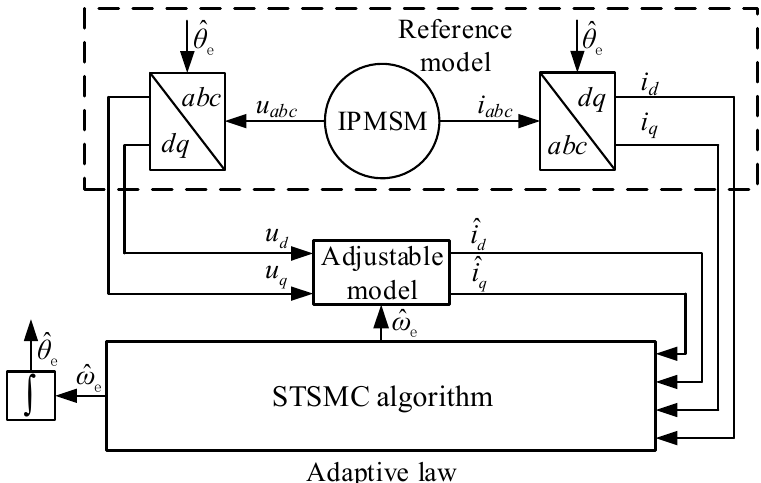
Figure 7. Block diagram of rotor position and speed estimation system.